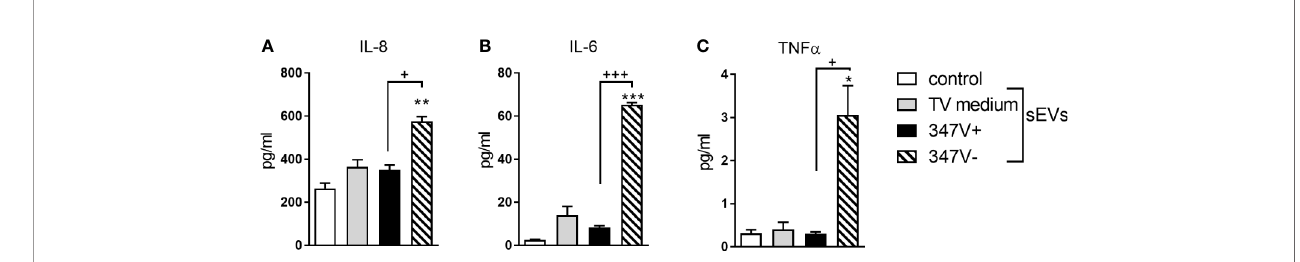
FIGURE 2 | sEVs from virus-negative TV but not virus-positive parasites induce multi-cytokine response in immune cells. PBMCs were treated with control no sEV, sEVs derived from TV medium, 347V+, and 347V- TV strains for 24 h. (A) IL-8, (B) IL-6, and (C) TNF- a protein levels were measured by MSD assays. Graphs represent data from PBMC donor X in duplicate and plotted as mean ± standard error of mean. Results are shown as protein levels normalized to cell viability. *p < 0.05; **p < 0.01; and ***p < 0.001 represent sEVs different from control. + p < 0.05 and +++ p < 0.001 represent 347V- different from 347V+.